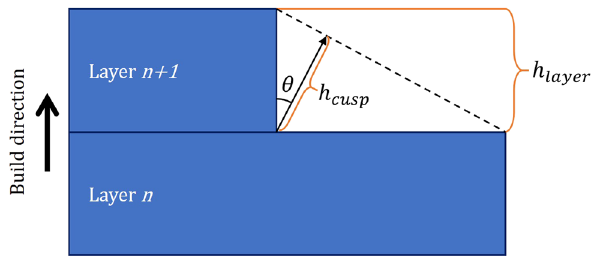
Figure 1: Illustration of the staircase e ff ect and the cusp height introduced by layered